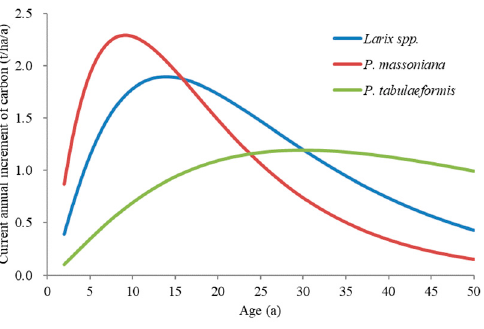
Figure 6. Current annual increment of carbon storage curves for the three plantation types.